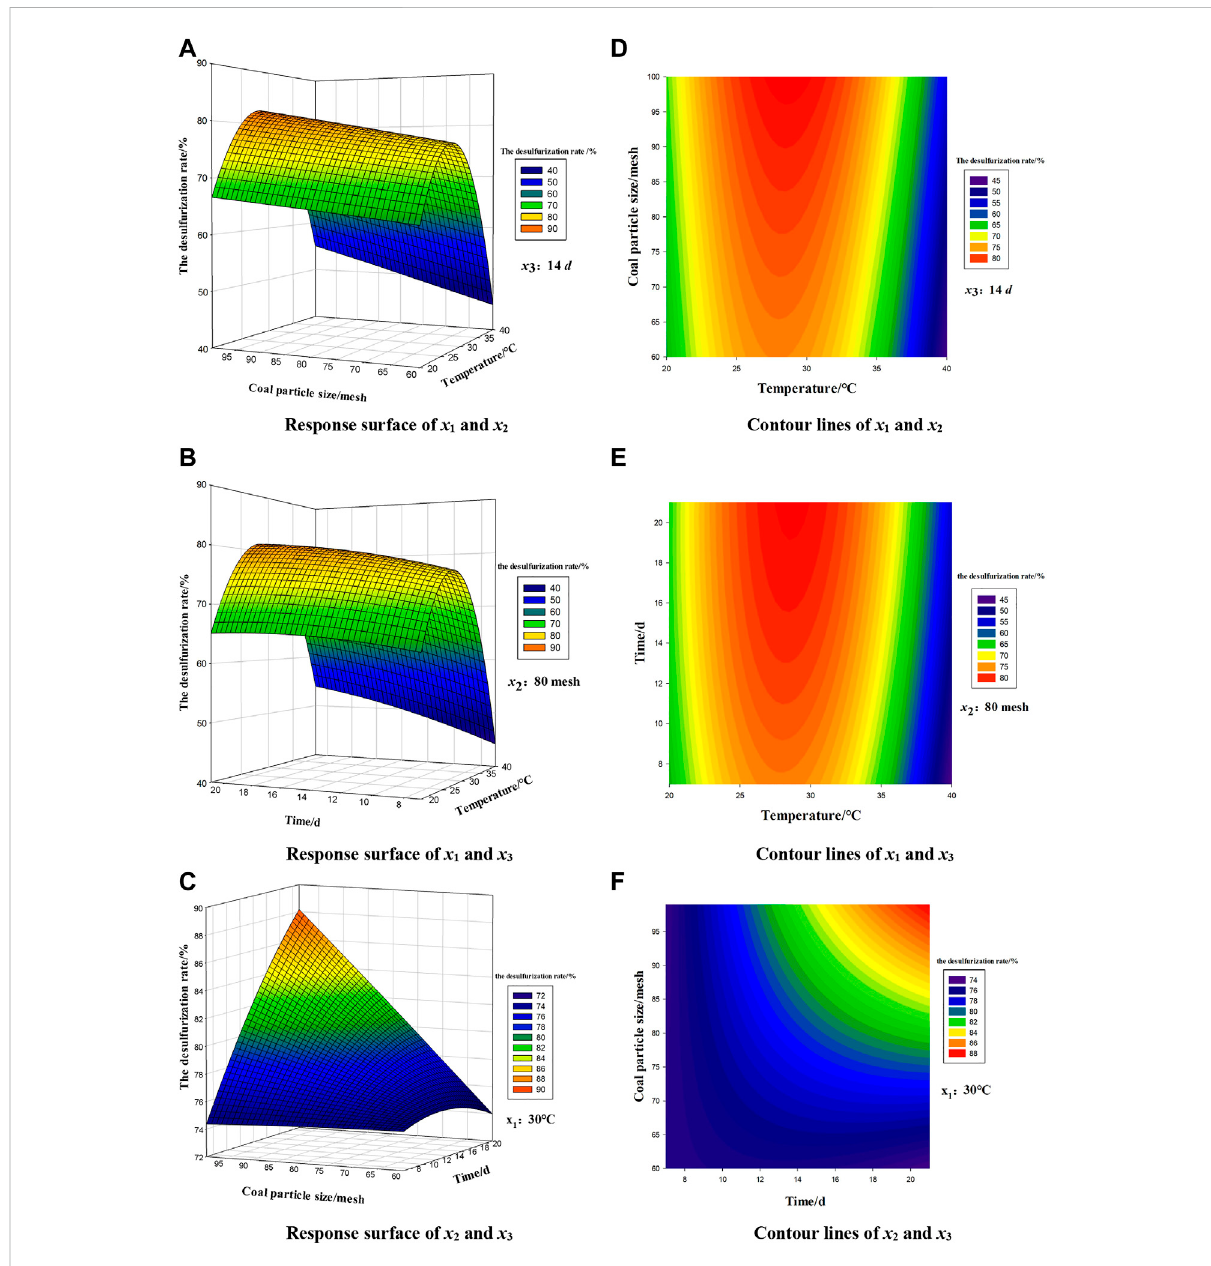
FIGURE 5 Contour lines and response surfaces between